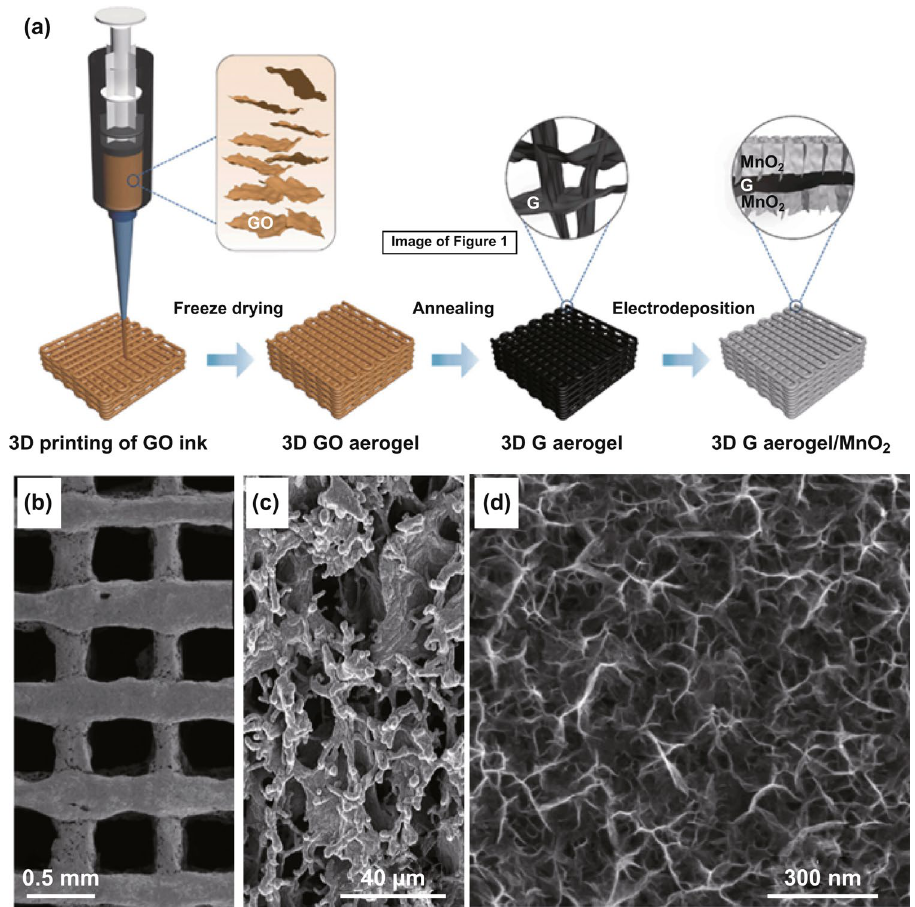
Fig. 19 a Schemes of the synthesis procedures of MnO 2 nanosheets deposited on 3D printed graphene aerogel lattices. b A top‑view SEM image of MnO 2 ‑coated 3D printed graphene aerogel. c , d SEM images of the deposited MnO 2 nanosheets at two magnifications. Adapted from Ref. [196] with